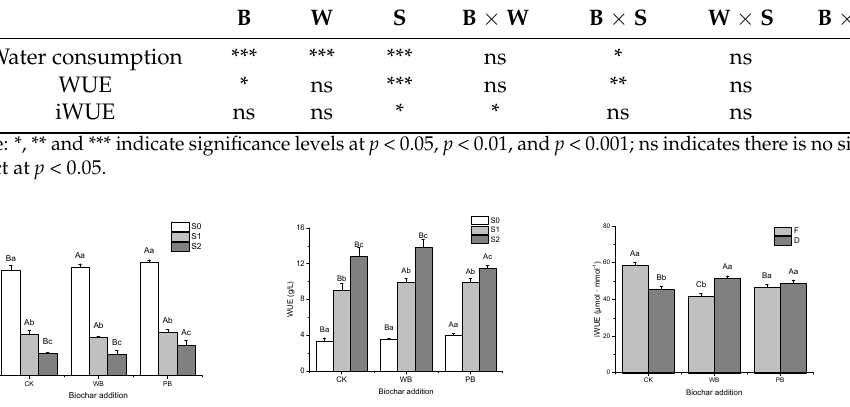
Table 6. Analysis of variance (ANOVA) for water consumption, instantaneous water use efficiency (iWUE), and plant water use efficiency (WUE) as affected by biochar addition (B), drought stress (W), and salt stress (S). B W